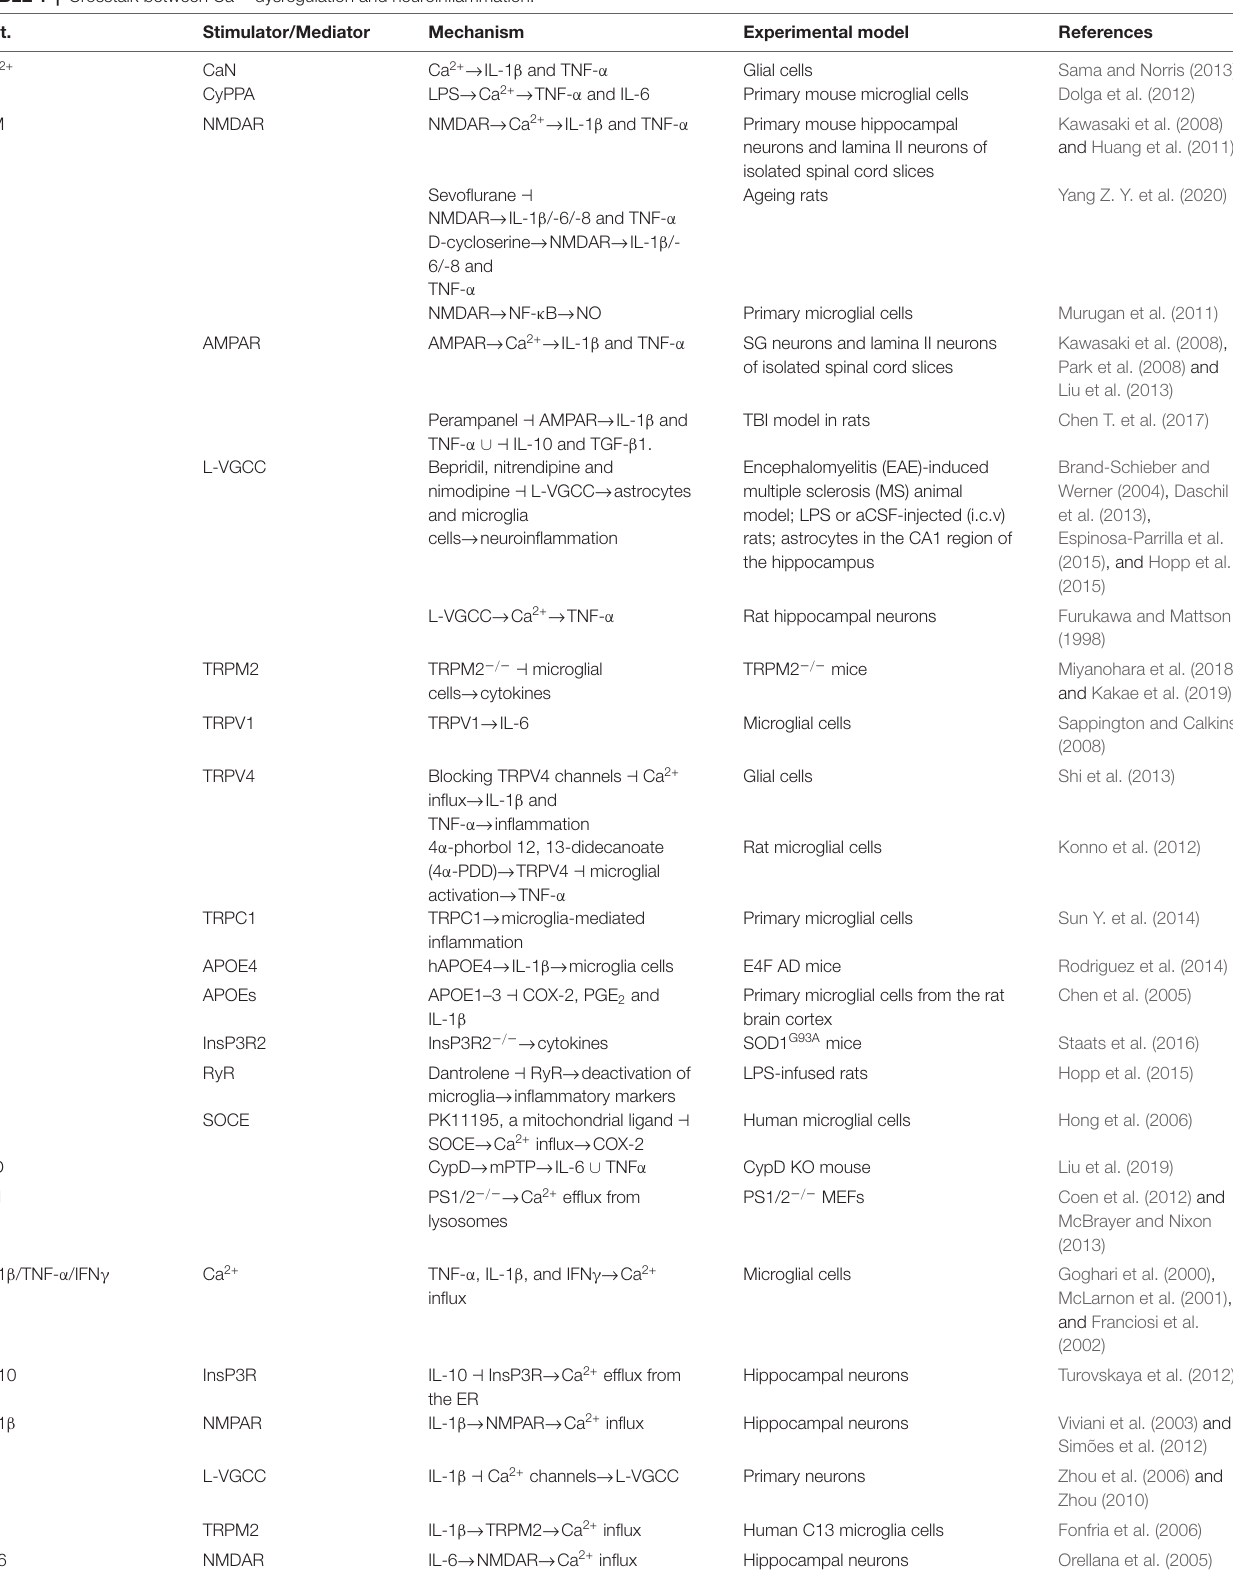
TABLE 1 | Crosstalk between Ca 2+ dysregulation and neuroinflammation.